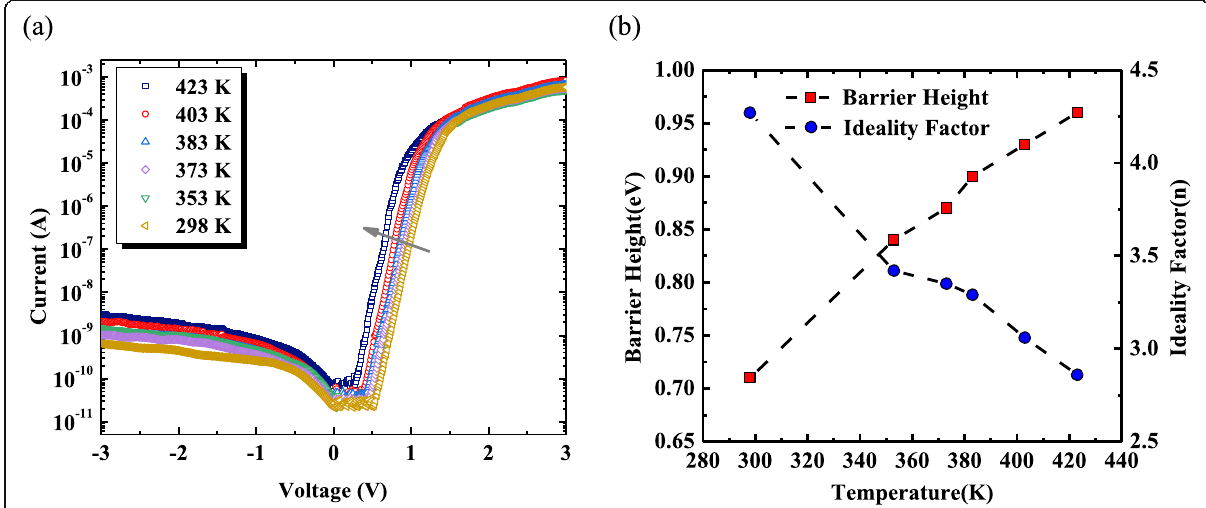
Fig. 2 Temperature-dependent I – V characteristics of PEDOT:PSS/ β -Ga 2 O 3 SBDs from 298 to 423 K ( a ) and Schottky barrier height ϕ b and ideality factor n of hybrid β -Ga 2 O 3 SBD ( b